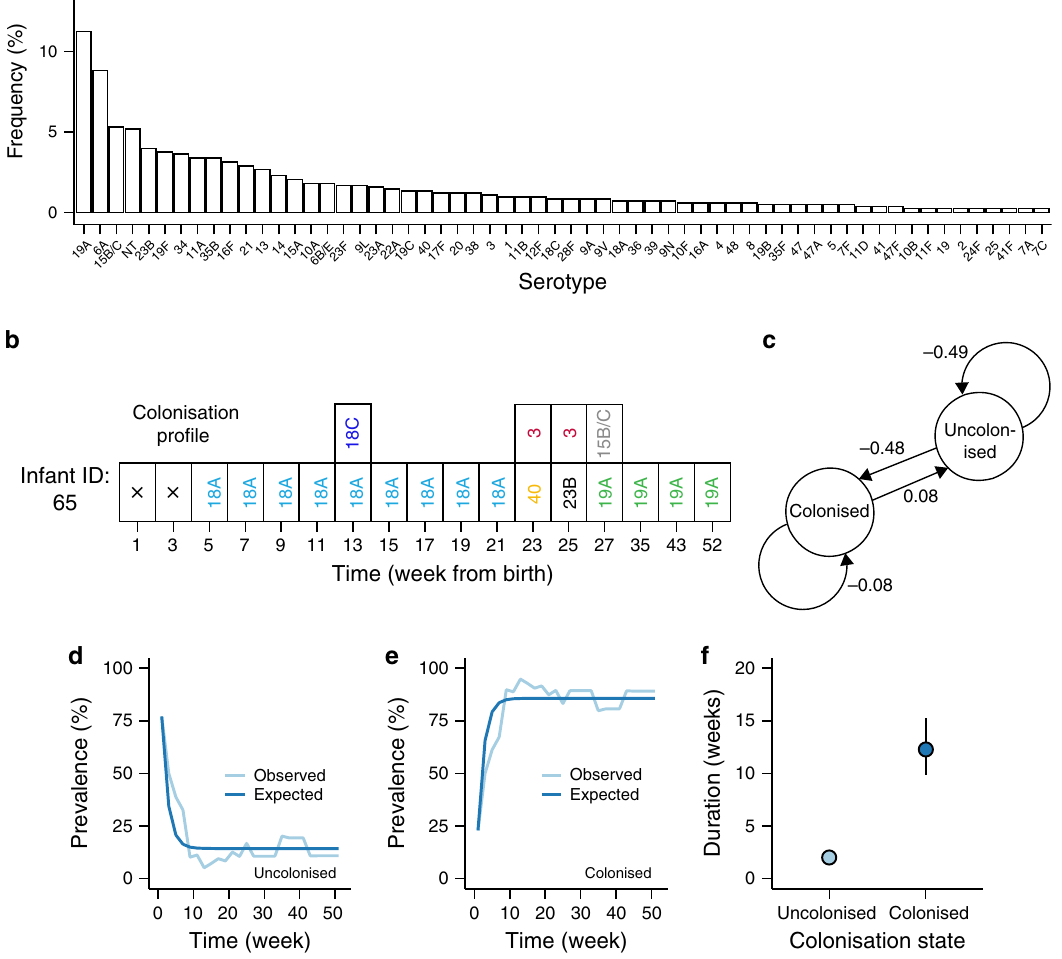
Fig. 2 Characteristics and dynamics of the extended pneumococcal strains. a Frequency of serotypes; each episode was counted once and serotypes with frequency >0.2% are shown. b An example of a colonisation pro fi le for infant ID: 65 showing different colonisation episodes. The sampling point marked with the cross (×) represents culture-negative pneumococcal samples (uncolonised). Different types of episodes are shown in ( b ) namely transient colonisation whereby an episode consisted of a serotype was detected at a single time point, extended colonisation which refers to an episode where the serotype was detected at multiple time points and multiple colonisation where there was co-occurrence of overlapping episodes of different serotypes at certain time points. c Schematic representation of the three-state multistate model showing colonised and uncolonised carriage states and the estimated transition intensities (rates) between the states. d , e Observed and expected prevalence of each colonisation state. f The inferred sojourn time (duration) in each colonisation state. The error bars represent the 95% con fi dence interval for the estimated mean